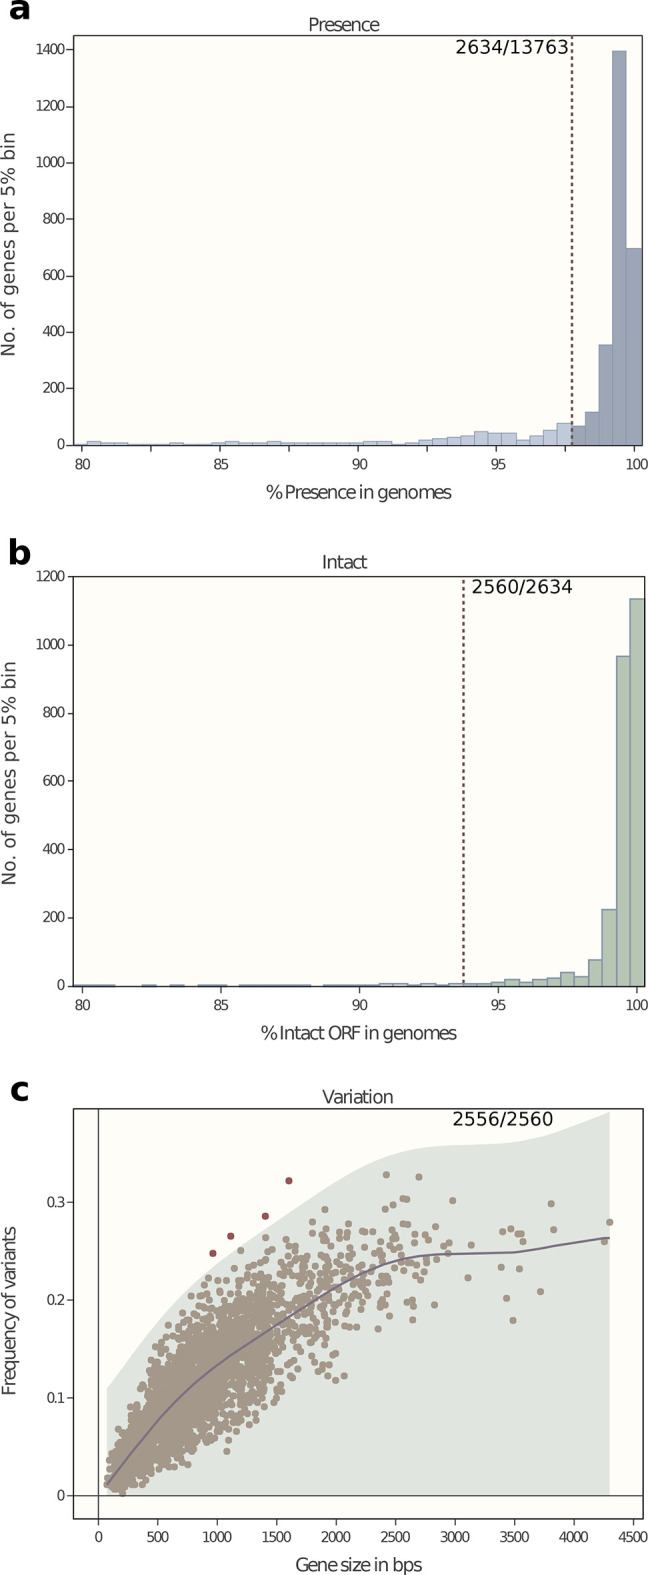
Criteria for inclusion in a cgMLST scheme of a subset of wgMLST genes based on their properties in a reference set of 442 genomes (https://tinyurl.com/Cdiff-ref). (a) Numbers of genes versus frequency (% presence) within the reference set. In total, 2634 genes satisfied the cut-off criterion of ≥98 % presence (dashed line). (b) Numbers of genes versus intact ORF (% intact ORF) within the 2634 genes from (a). Overall, 2560 genes satisfied the cut-off criterion of ≥94 % intact ORF (dashed line). (c) Frequency of allelic variants versus gene size among the 2560 genes from (b). The genetic diversity was calculated using the GaussianProcessRegressor function in the sklearn module in Python. This function calculates the Gaussian process regression of the frequency of genetic variants on gene sizes, using a linear combination of a radial basis function kernel (RBF) and a white kernel [57]. The shadowed region shows a single-tailed 99.9% confidence interval (≤3 sigma) of the prediction. Altogether, 2556 loci fell within this area and were retained for the cgMLST scheme, while four were excluded due to excessive numbers of alleles.